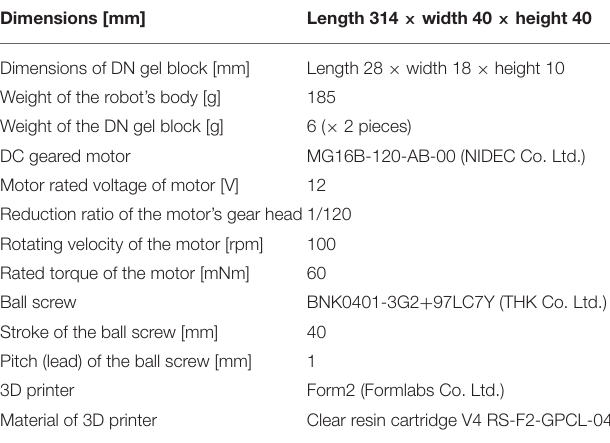
TABLE 1 | The specifications of the inchworm search